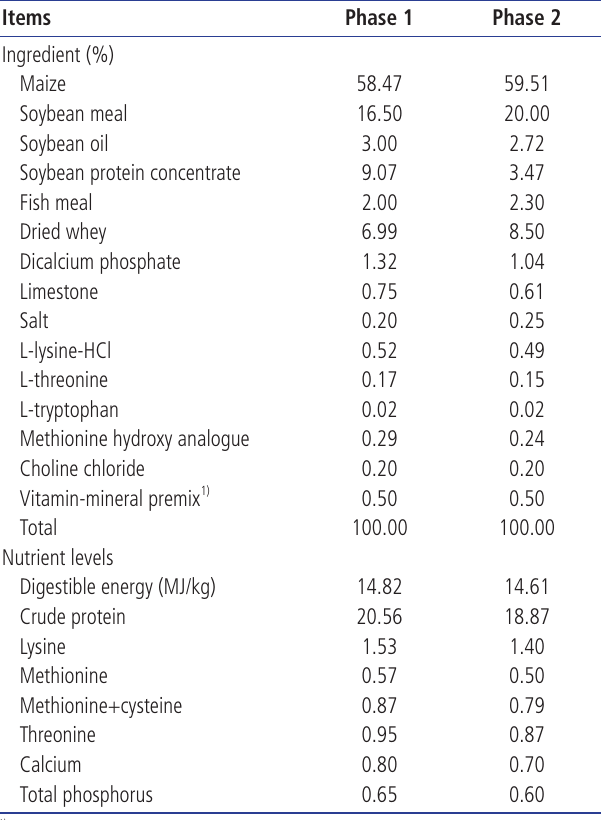
Table 2. Analyzed Zn concentration in diets for